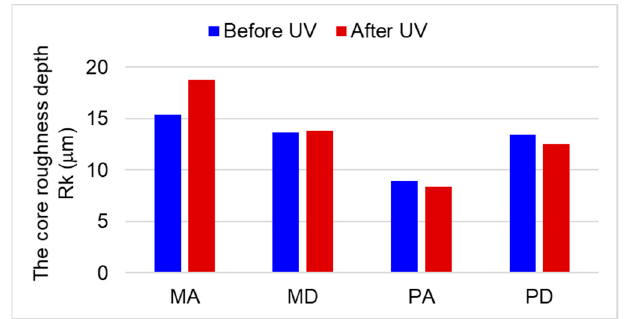
Figure 7. Quantitative analysis of the core roughness depth (Rk) before and after UV treatment.